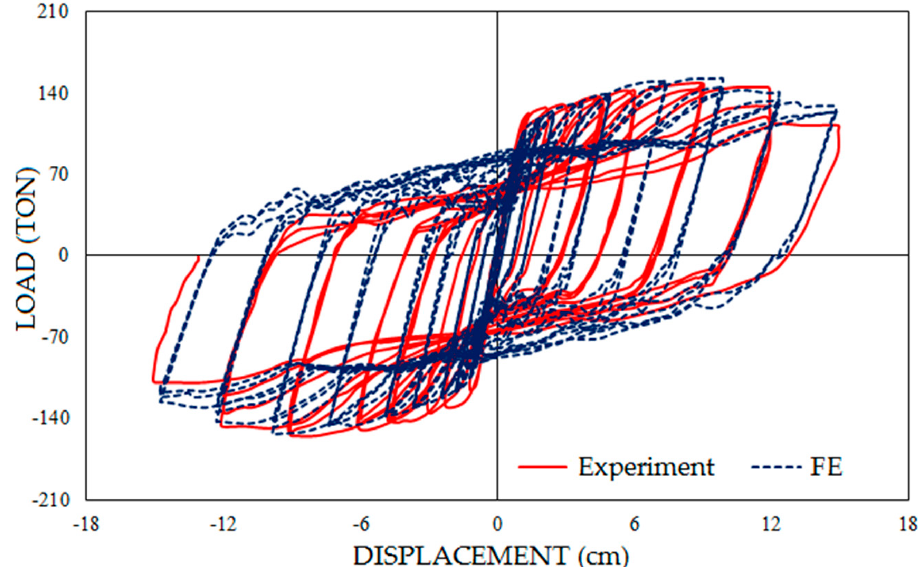
Figure 2. Comparison between hysteresis graphs of the experimental specimen and FE model.